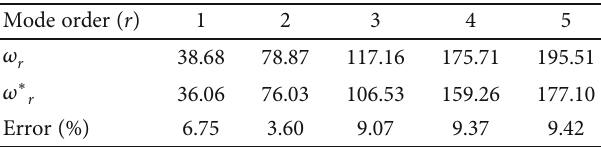
Table 6: Natural frequencies of the original system and the modi fi ed